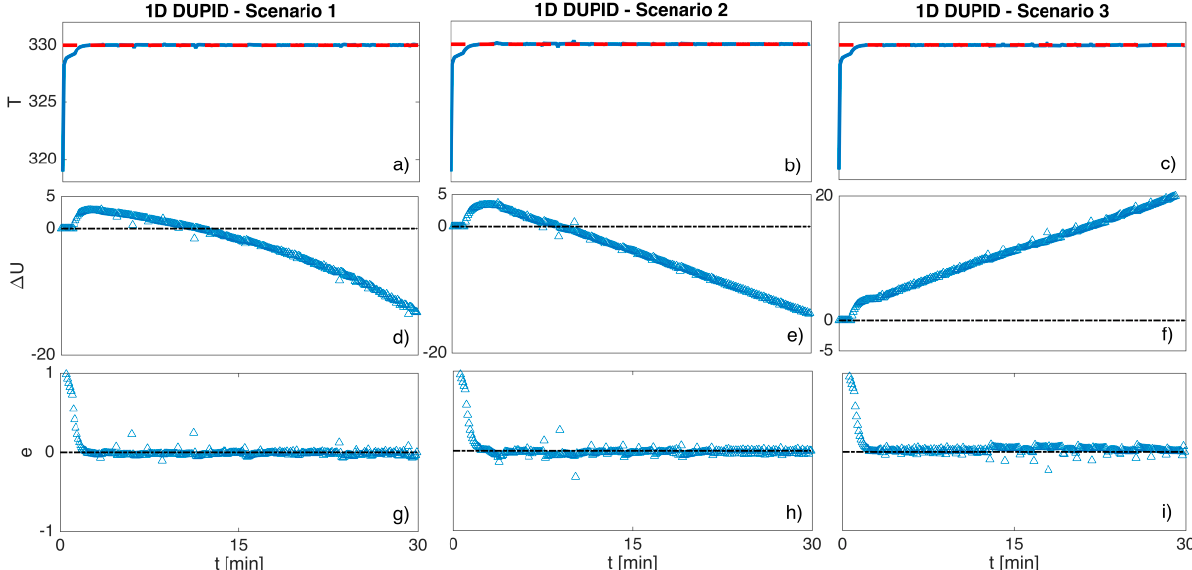
Figure 8. The plant response under 1D DUPID control in all three scenarios. The figure is structured in three rows of three pictures, in the first row ( a – c ) the plant output (blue line) and the set point (red dashed line) are plotted; in the second row ( d – f ) the incremental value is given (blue markers); in the third row ( g – i ) the resultant control error (blue markers) is plotted against the zero error line (black dashed line).